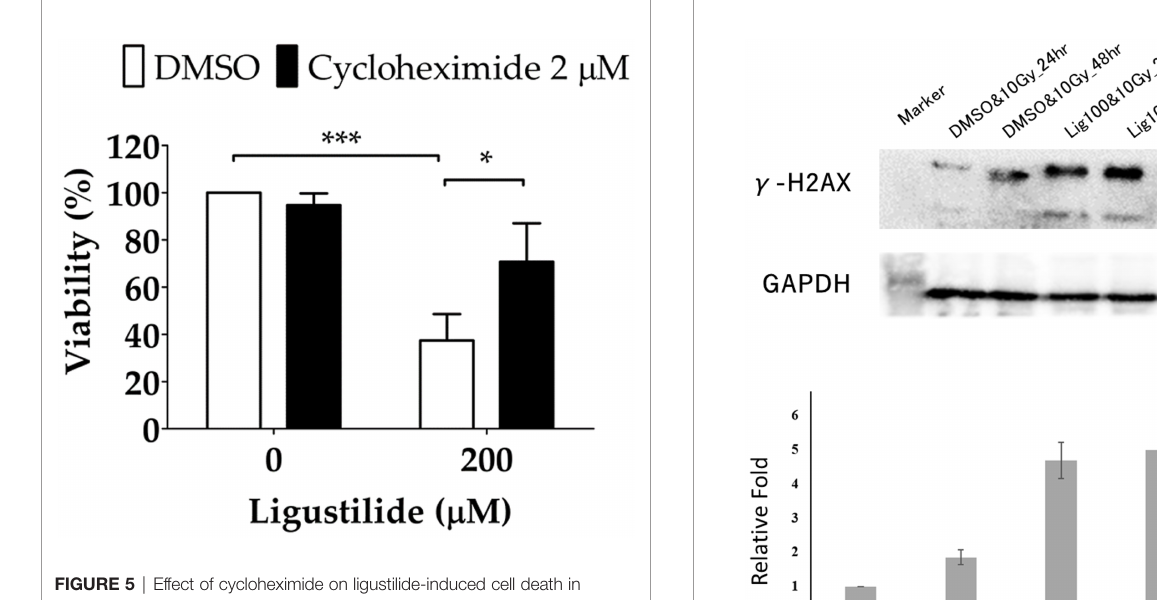
FIGURE 5 | Effect of cycloheximide on ligustilide-induced cell death in hypoxic TW2.6 cells. Cells were pretreated with cycloheximide (2 m M) for 30 min and incubated with ligustilide for another 24 h under hypoxia. Cell viability was then measured by MTT assay. Data are expressed as mean ± SEM ( n ≥ 3). *P-valve < 0.05; ***P-valve < 0.001.